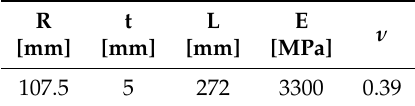
Table 3. Geometrical cylindrical data.